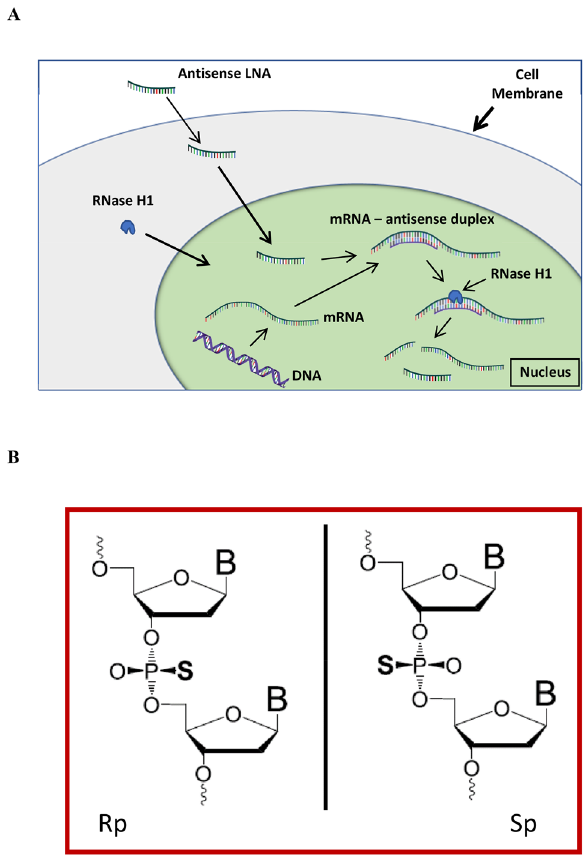
Figure 1. Antisense mechanism ( A ) and phosphorothioate ( B ). ( A ) The use of LNA oligonucleotides as inhibitors of disease—forming proteins, or reduction of harmful RNA, is based on specific hybridization to target mRNA. This duplex recruits the cellular enzyme RNase H1 that degrade the hybridized mRNA. The LNA oligonucleotide remains intact under this process and will repeatedly trigger degradation of further target mRNA; (B ) the two steric configurations Rp and Sp of the phosphorothioate linkages between the nucleobases of phosphorothioate